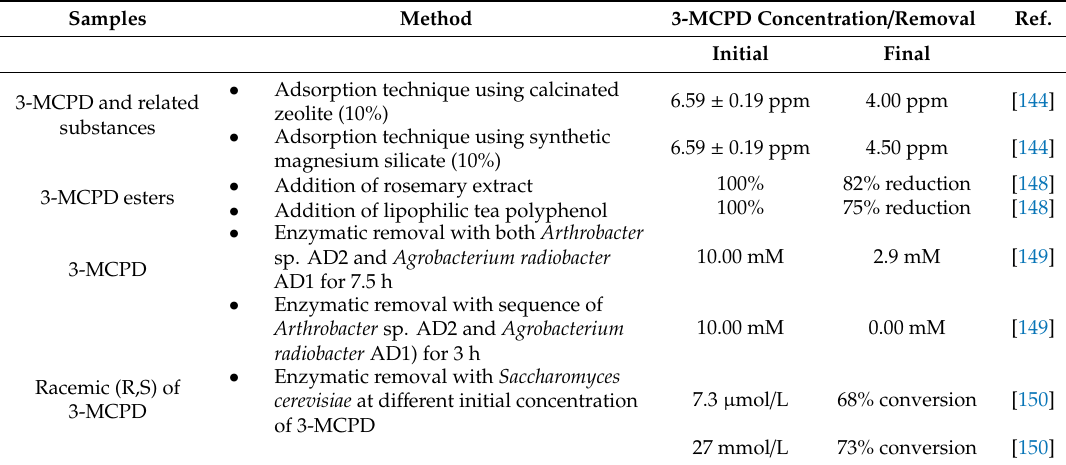
Table 1. E ff ects of mitigation on total 3-MCPD